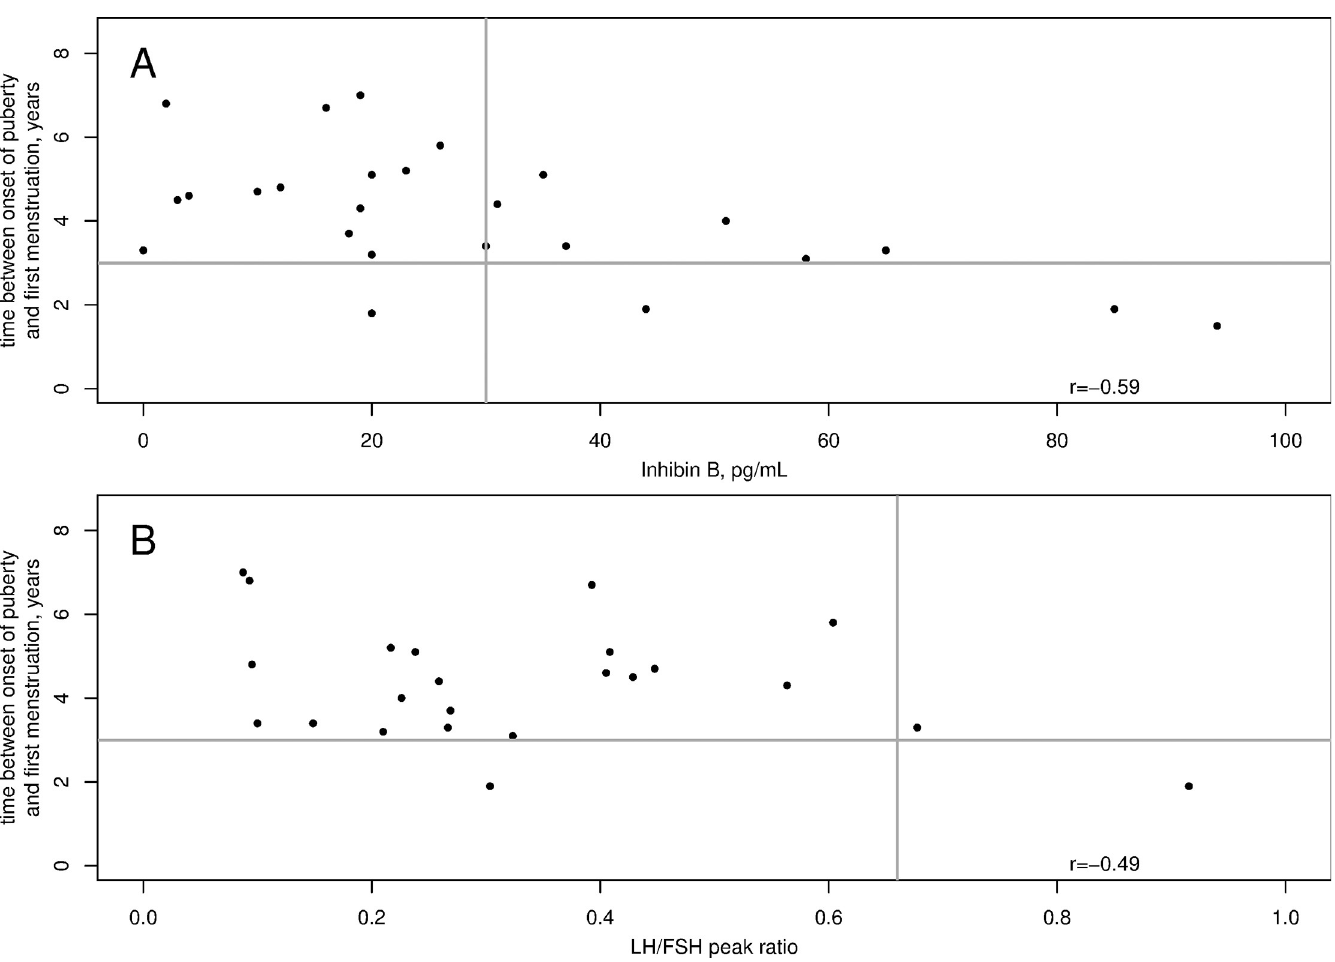
Fig 2. Time between onset of puberty and first menstruation vs the inhibin B concentration (A) or LH/FSH peak ratio (B) in 25 girls with untreated CPP. Each dot is one girl. Data from two patients are not included in B, as their LH/FSH peak ratios were 5.68 and 2.9; their times between onset of puberty and first menstruation were 1.5 and 1.8 years,